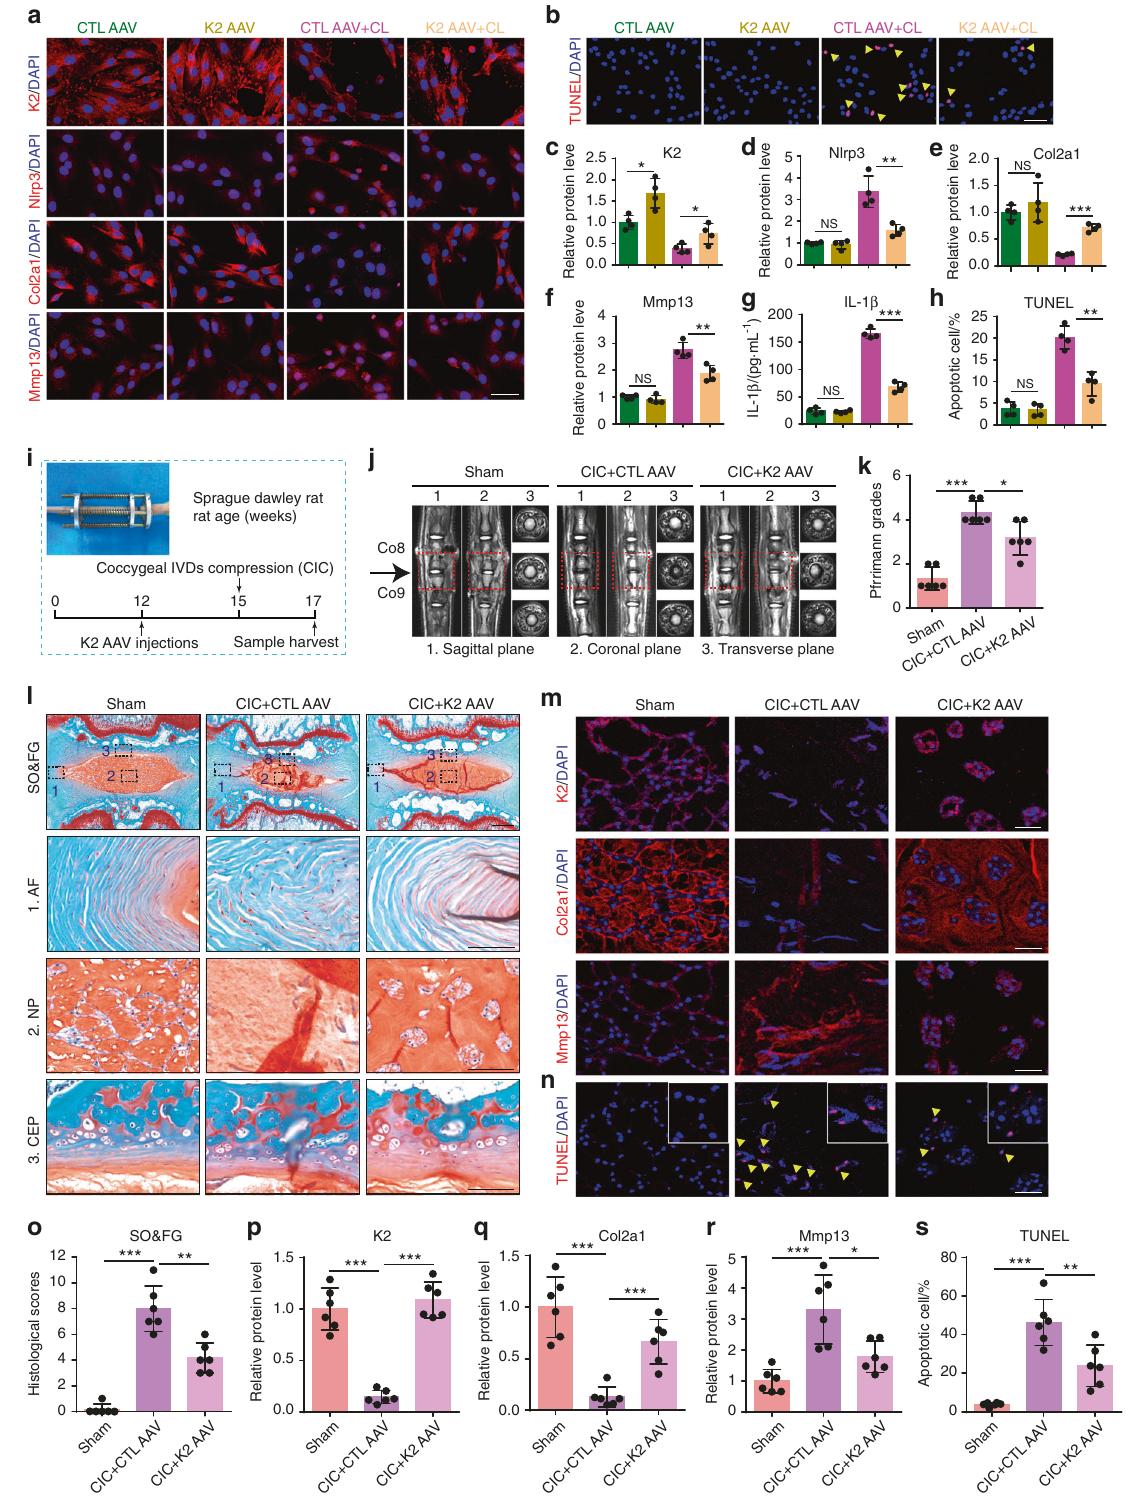
Fig. 6 Administration of AAV-Kindlin-2 largely alleviates IVDD progression. a , c – f IF staining of K2, Nlrp3, Col2a1, and Mmp13 in human primary NP cells infected with control adeno-associated virus (CTL AAV) or K2 AAV, and then treated with or without compression loading (CL). Scale bar, 50 μ m. n = 4. g The levels of IL-1 β in the conditioned media of cultured human NP cells treated as in ( a ), as detected by ELISA. n = 4. b , h TUNEL staining of primary human NP cells, which were treated as in ( a ). Scale bar, 50 μ m. n = 4. i Overview of the experimental set-up of rat coccygeal IVDs compression (CIC) model with or without K2 AAV treatment. j , k Magnetic resonance imaging (MRI) and P fi rrmann grades of coccygeal IVDs in rats treated as in (i). n = 6. l , o SO&FG staining and histological scores of coccygeal IVDs in rats treated as in ( i ). Scale bar, 500 or 100 μ m. n = 6. m , p-r IF staining of K2, Col2a1, and Mmp13 in NP tissues in coccygeal IVDs of rats treated as in ( i ). Scale bar, 50 μ m. n = 6. n , s TUNEL staining of NP tissues in coccygeal IVDs of rats treated as in ( i ). Scale bar, 50 µm. n = 6. * P < 0.05, ** P < 0.01, *** P <